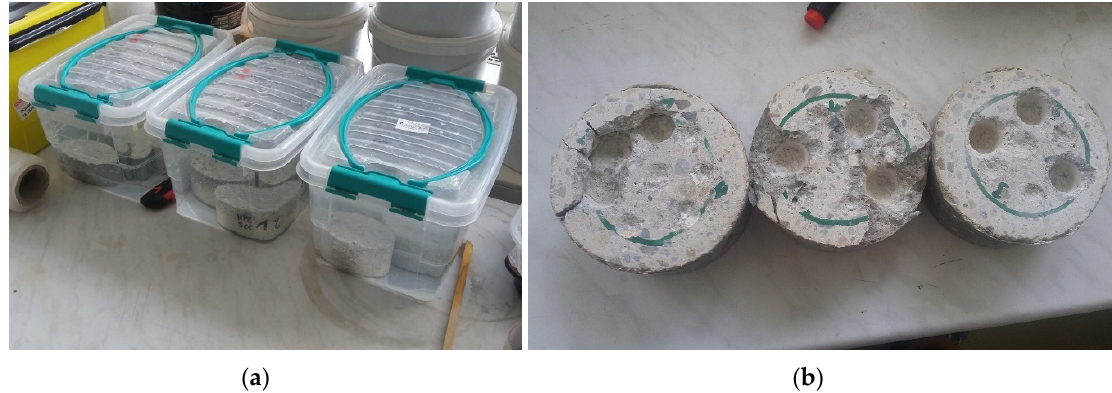
Figure 5. The process of the modified NORDTEST NT Build 443: ( a ) samples submerged in the chloride solution; ( b ) samples after drilling.